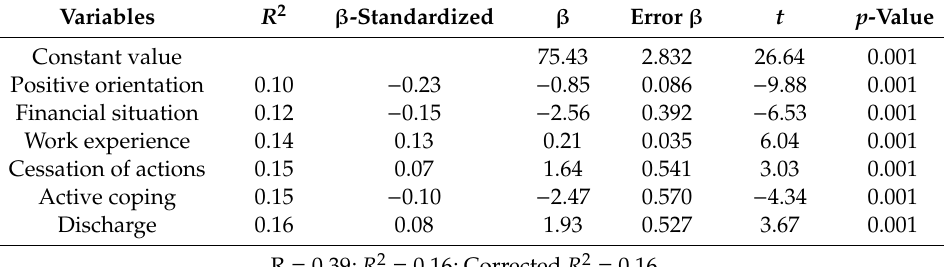
Table 5. Regression summary—predictors of work-related